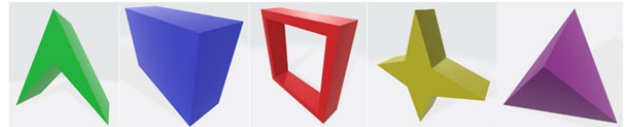
Fig. 11. Non-Convex Pieces (1 to 5 from left to right) of the data set LLCY15 from Liu et al. (2015)